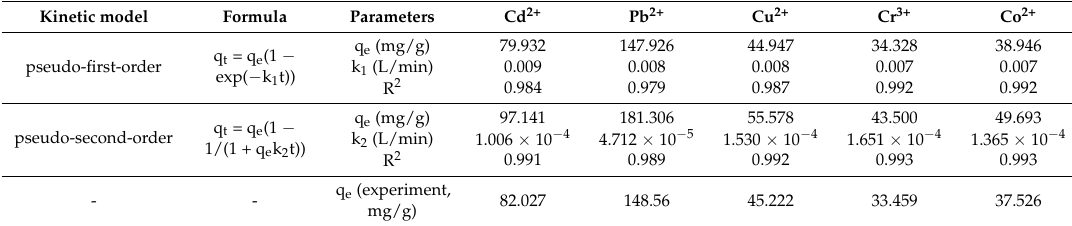
Figure 6. Effect of adsorption time on ( A ) Cd 2+ , ( B ) Pb 2+ , ( C ) Cu 2+ , ( D ) Cr 3+ and ( E ) Co 2+ sorption by Alg-EDTA. Table 1. Kinetic parameters for heavy metal ions sorption onto the Alg-EDTA.